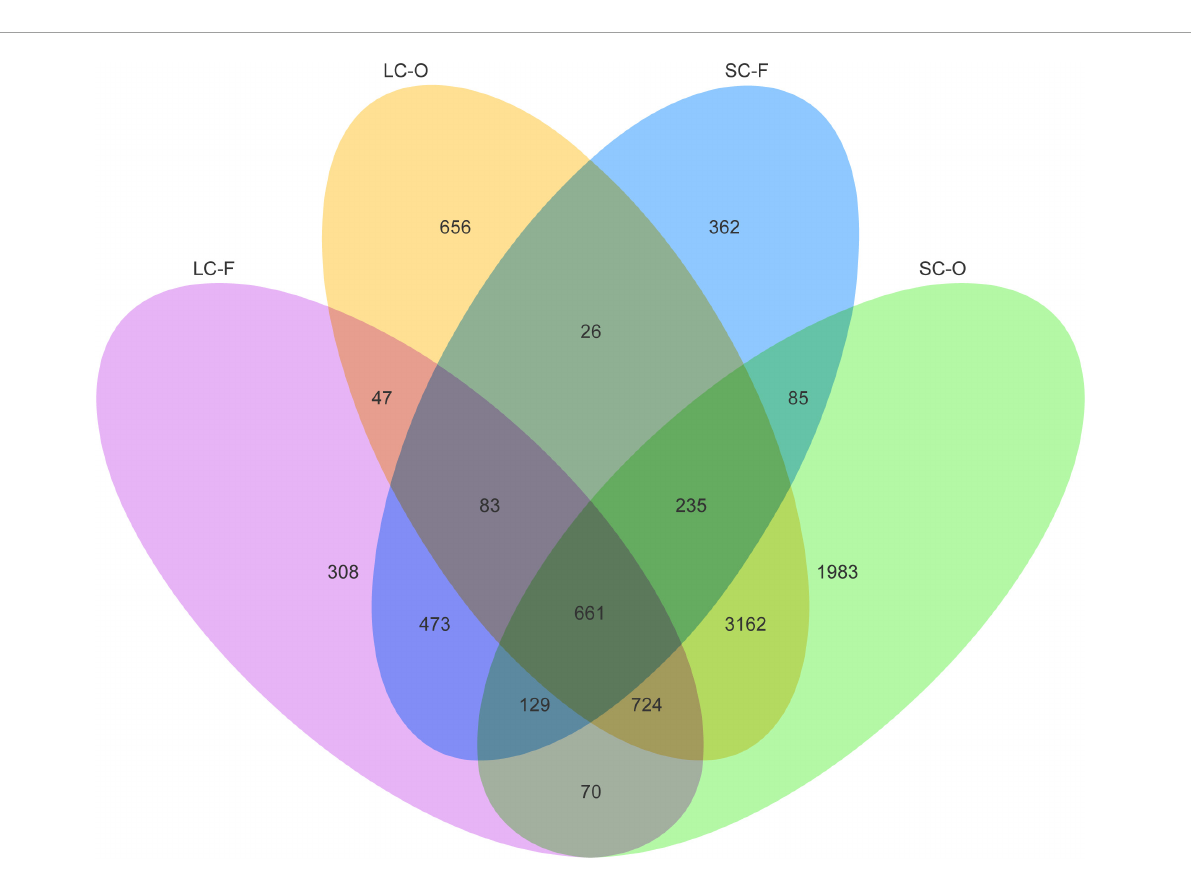
FIGURE2 Venn diagram showing the number of shared operational taxonomic units (OTUs) identified from each